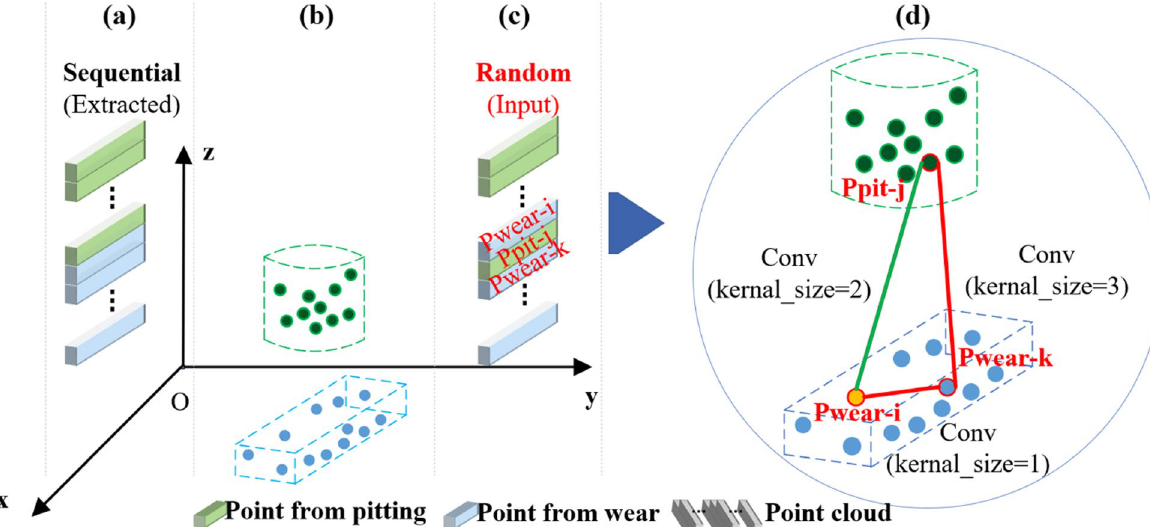
Fig. 4 Ordered/unorganized point cloud and the receptive field corresponding to different convolution kernel sizes. a The ordered point cloud extracted from the gear discretization; b Result of dispersing pitting defects and wear defects into point clouds; c The point cloud, result of dispersing pitting defects and wear defects, input into the neural network after random shuffle; d Representation of the receptive field corresponding to different convolution kernel sizes in the network. In the circular region d , the orange dot represents the convolution of kernel size 1, the green line represents the convolution of kernel size 2, and the red triangle represents the convolution of kernel size